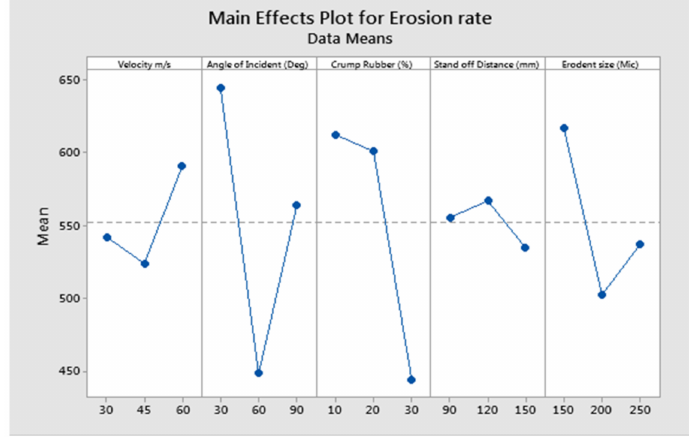
Figure 3. Effect of control factors on solid particle erosion.